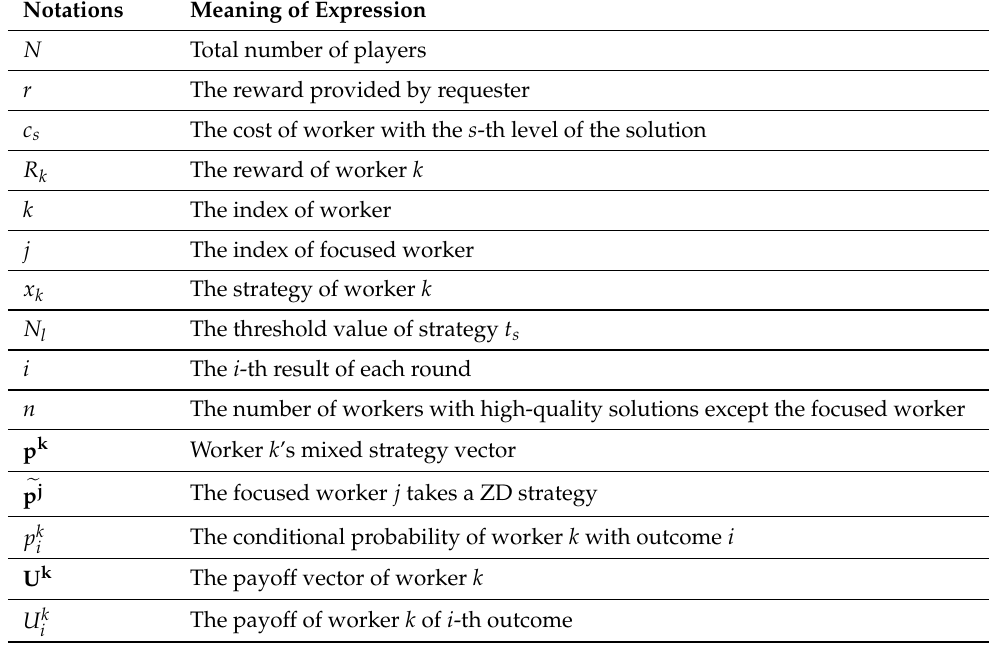
Table 1. Symbolic